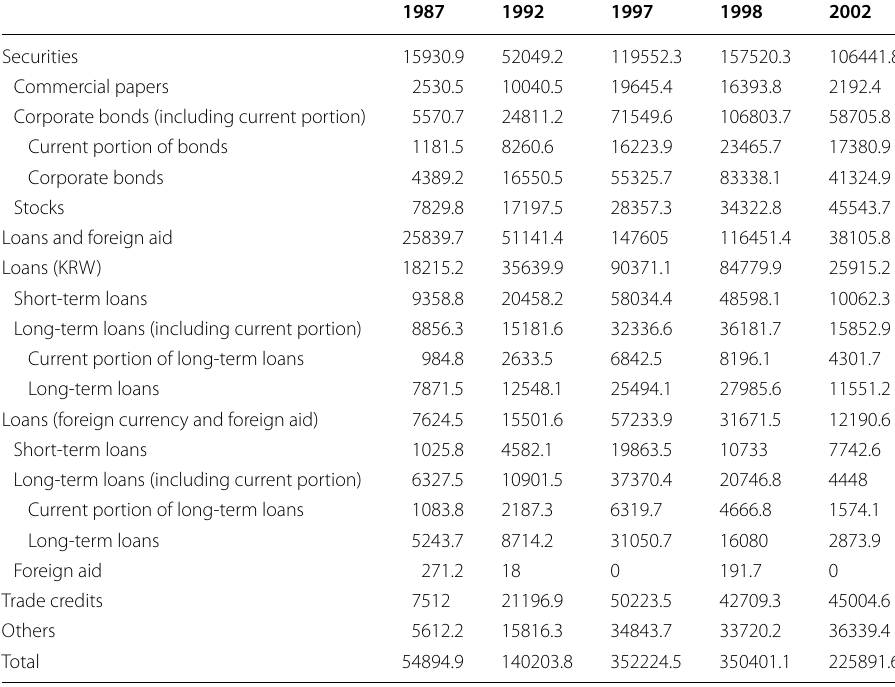
Table 2 Liabilities of the chaebol (using table R , in Bil.